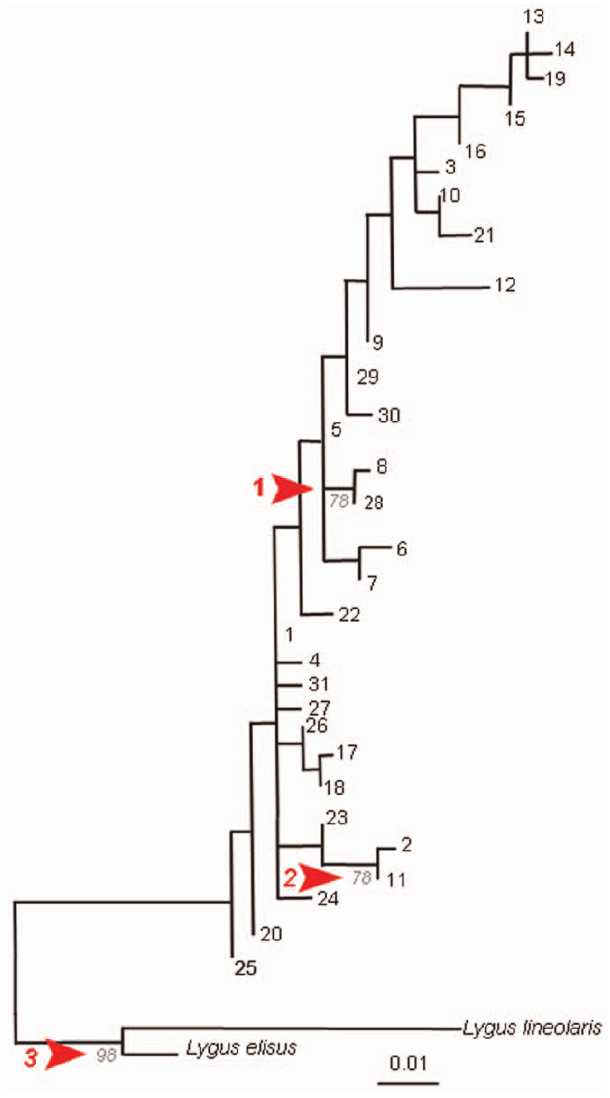
Figure 2. A ML tree representing a common topography of the 31 L.hesperus haplotypes identified in this study. Lineolaris refers to L. lineolaris , Elisus refers to L. elisus , and all numbers at the end of the branches represent haplotypes whereas numbers at the three branches indicate bootstrap support. The three arrows label strong bootstrap support at the nodes indicated. Sequence divergence is noted by the ruler.